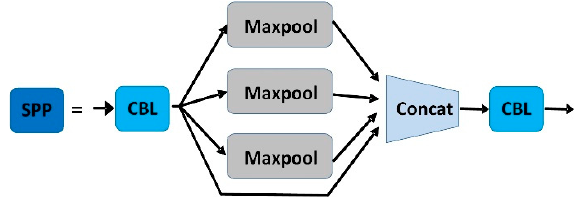
Figure 5. The structure of SPP.